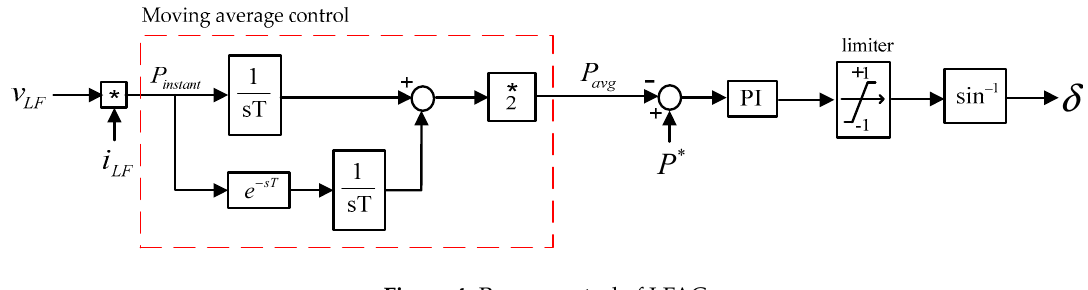
Figure 4. Power control of LFAC.